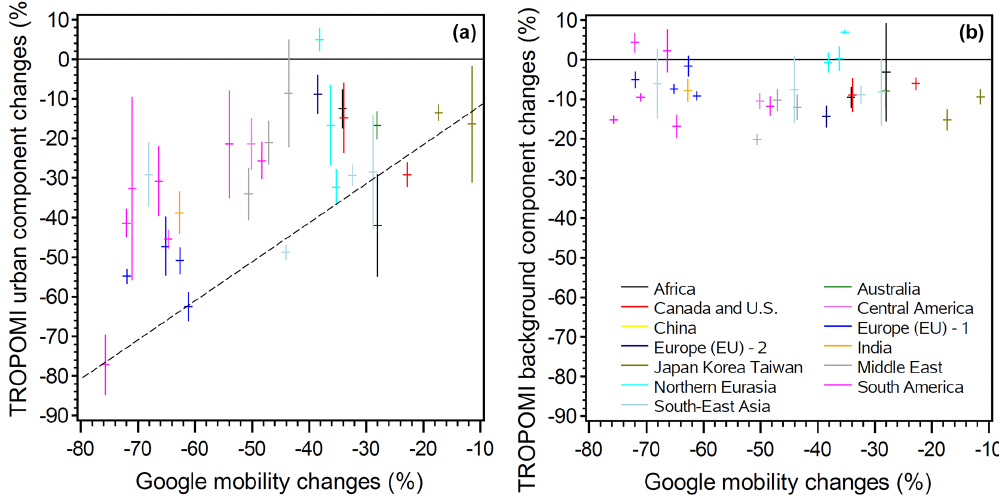
Figure 16. A scatter plot of Google mobility statistic changes vs. TROPOMI NO 2 VCD changes for (a) the urban and (b) background components during the period from 16 March to 15 June 2020 compared to the baseline period. The Google mobility statistic changes show the difference with the pre-lockdown period (3 January–6 February 2020) in percent. For TROPOMI, the difference is between the 2020 and the 2018–2019 average. Each symbol represents one country; the dot colour demonstrates the region as shown in the legend. Only countries with at least two cities used in this study are included in this plot. The correlation coefficient between the two data sets is 0.62. The dashed y = x line is shown for reference. The error bars represent the standard